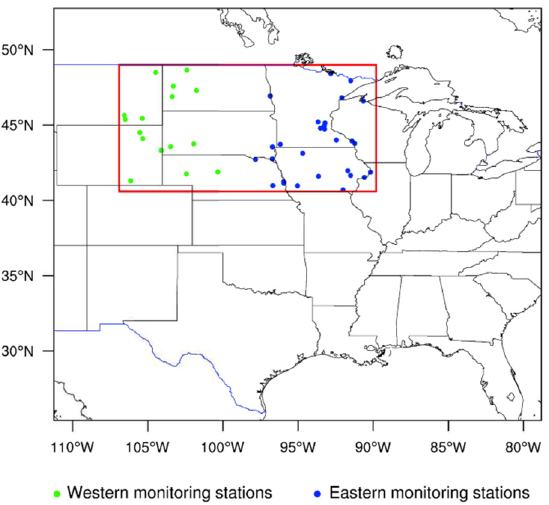
Figure 1. Modeling domain and location of hourly meteorology and air quality monitoring stations within the area of analysis centered on the Northern Great Plains.